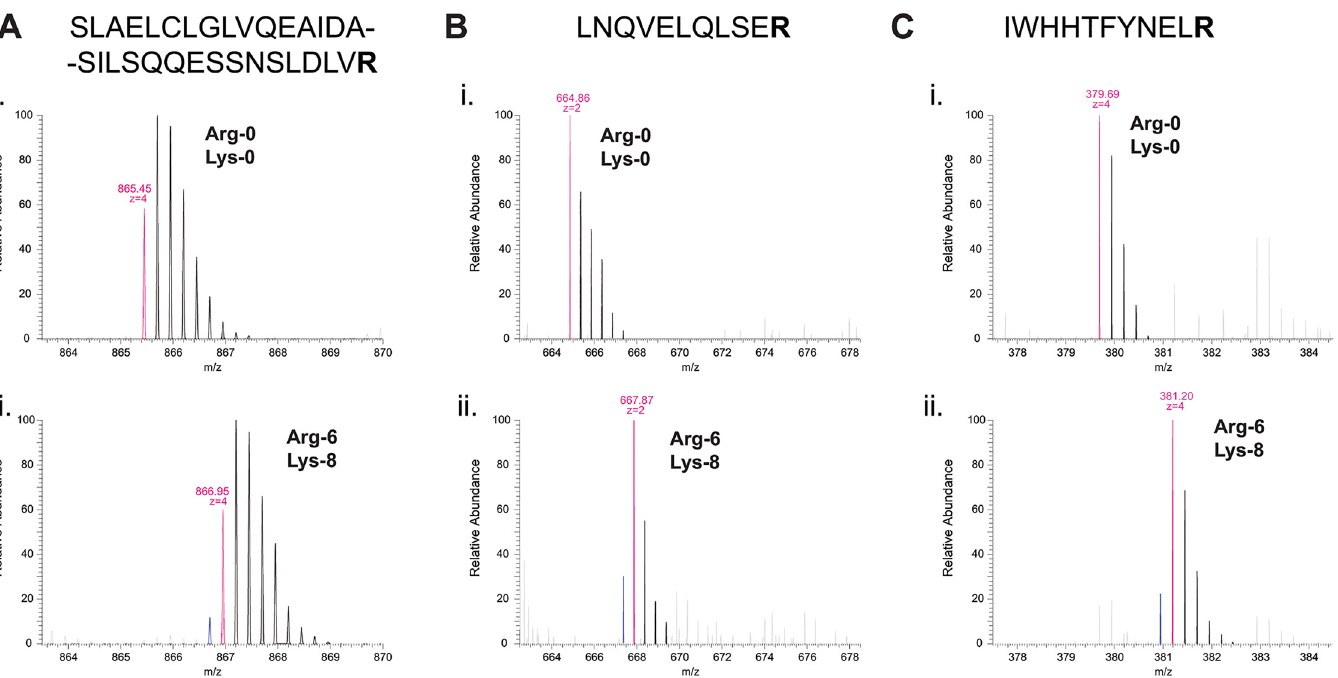
Fig 4. Arginine-containing peptides from cells grown in 13 C 6 -arginine (Arg-6) exhibit a single lower-molecular-mass peak that indicates loss of a single “ heavy ” atom from a portion of the Arg-6 pool. Mass spectra of tryptic peptides (SLAELCLGLVQEAIDASILSQQESSNSLDLVR, LNQVELQLSER, and IWHHTFYNELR, in (A), (B) and (C), respectively) from S . pombe (A, B) Mto2[17A]-GFP and (C) actin, isolated from car2 Δ arg1-230 lys3-37 cells grown in either (i) unlabeled arginine (Arg-0) and unlabeled lysine (Lys-0), or (ii) 13 C 6 -arginine (Arg-6) and 13 C 615 N 2 -lysine (Lys-8), as indicated. In peptides from cells grown in Arg-6, the single “ pre-peak ” (indicated in blue) indicates conversion of a portion of Arg-6 to 13 C 5 -arginine (Arg-5). Masses of monoisotopic peaks for each growth condition (i.e., assuming no conversion of labeled arginine) and inferred peptide charge-states are indicated in magenta.